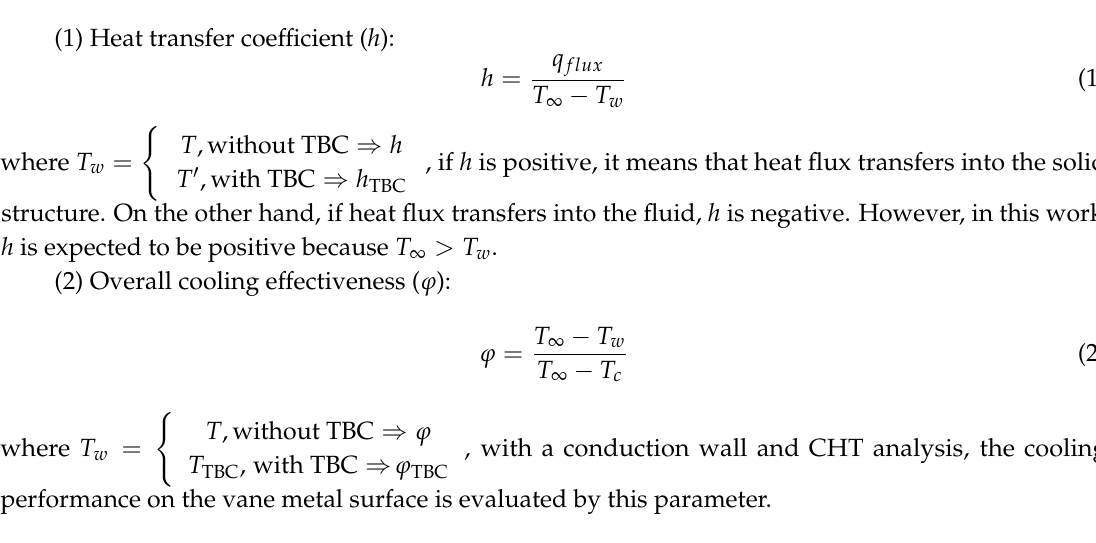
Figure 1. Evaluation of the thermal parameters used in this work [31]. TBC: thermal barrier